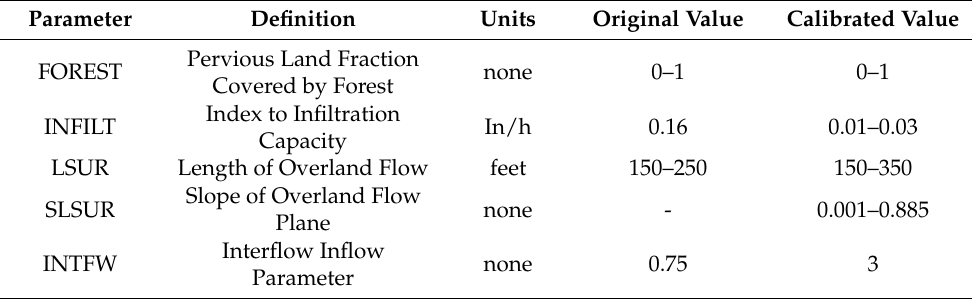
Table 3. Calibrated values of Hydrological Simulation Program-Fortran (HSPF)